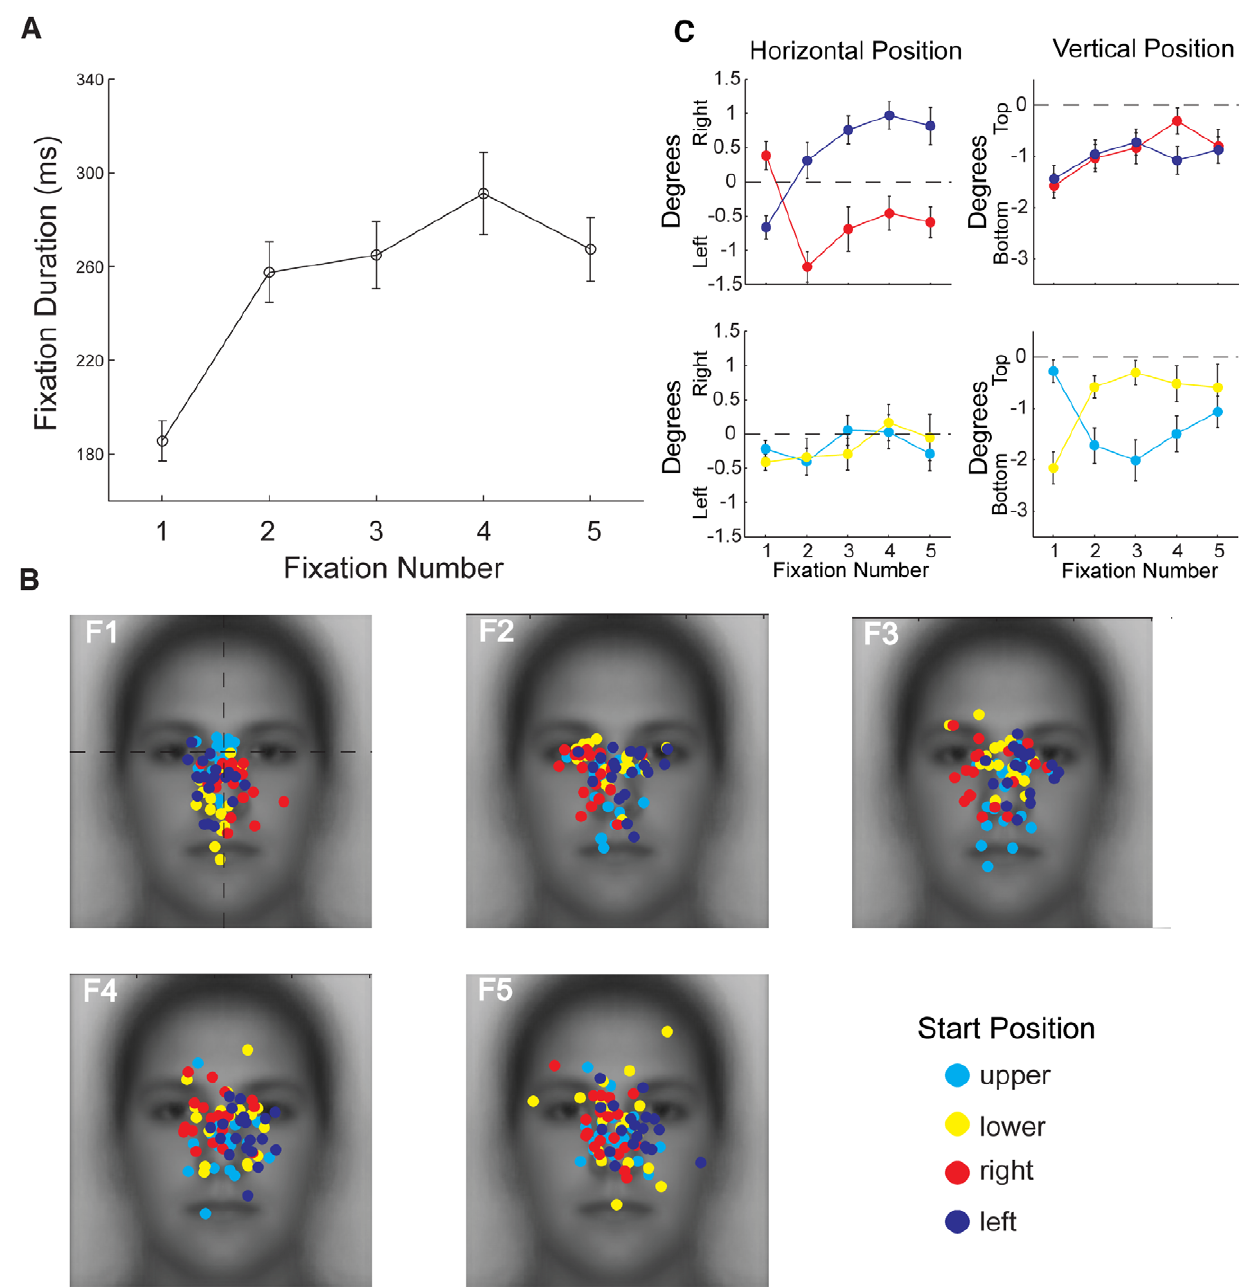
Figure 6. Evolution of fixations over ordinal number for upright faces. ( a ) Average duration of each ordinal fixation. Note the much shorter duration of the first than subsequent fixations. ( b ) Distribution of individual participants’ fixation locations broken down by start position for each ordinal fixation (F1–F5). Fixation locations for the first fixation were generally toward the center of the face, but with a relative tendency to fall closer to the start position. Fixation locations for subsequent fixations tended to fall on the side of the face opposite the start position. For example, on the first fixation, fixations for the left start position show a tendency to the left side of the face while those for the right start position show a tendency to the right side of the face. On subsequent fixations, these tendencies reverse with the right start position showing a tendency to the left side of the face and the left start position to the right side of the face. A similar effect can be observed for the upper and lower start positions. ( c ) Average locations from (b). The two left plots give the average horizontal position of fixations in degrees of visual angle relative to the midline of the face (dotted line). The two right plots give the average vertical position relative to the vertical position of the eyes (Figure 3b). Note the strong effect of the left and right start positions on horizontal but not vertical position (top panels) and the opposite effect for the upper and lower start positions (bottom panels). Error bars indicate the between-subjects standard error. doi:10.1371/journal.pone.0031106.g006 Number only (F(3,51)=29.90, p , 0.001). As with upright faces, the the second fixation was also shorter than fixations 3–5 (all t . 3.46, duration of the first fixation was shorter than fixations 2–5 (all p , 0.01). To directly compare upright and inverted faces, fixation t . 5.18, p , 0.001). However, unlike upright faces, the duration of durations were entered into an ANOVA with Fixation Number and